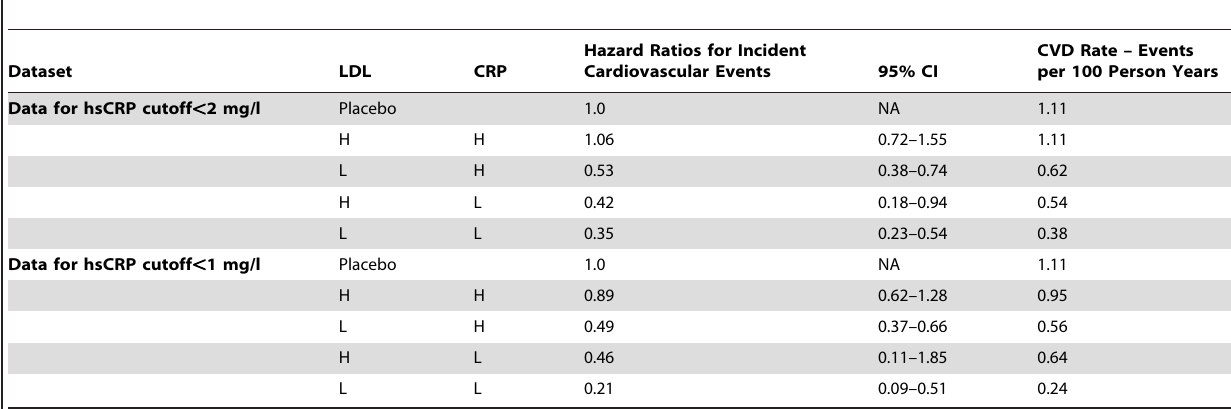
Table 4. JUPITER results for cardiovascular events - Hazard ratios for incident cardiovascular events in JUPITER according to achieved concentrations of LDL cholesterol and hsCRP after initiation of rosuvastatin.